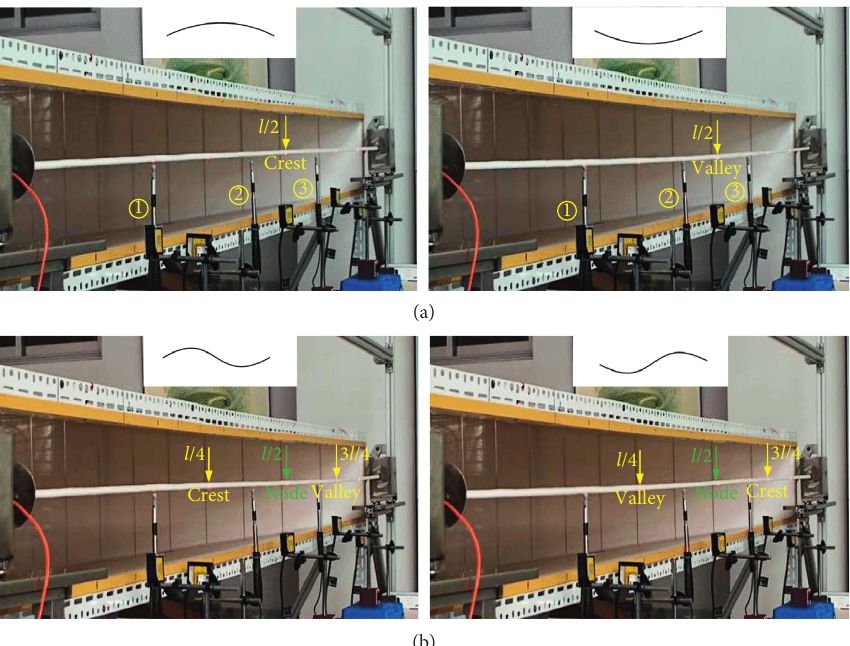
Figure 11: Galloping profile captured in the wind tunnel test. (a) 1 st in-plane mode ( U � 0.85m/s). (b) 2 nd in-plane mode ( U � 1.207m/s).